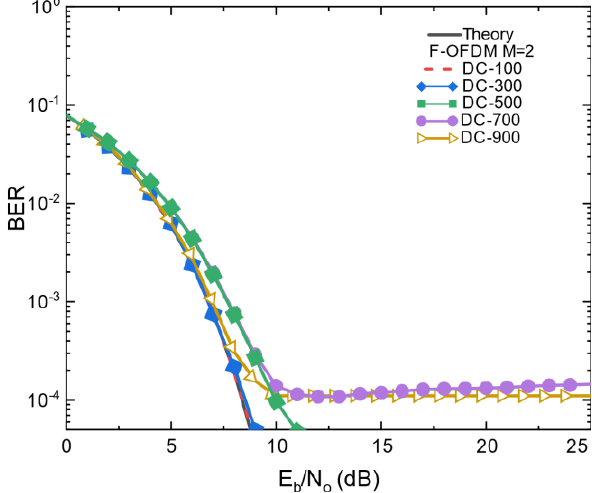
Figure 5. BER performance as a function of E b /N o for F-OFDM with 2-PAM and 200 AC.